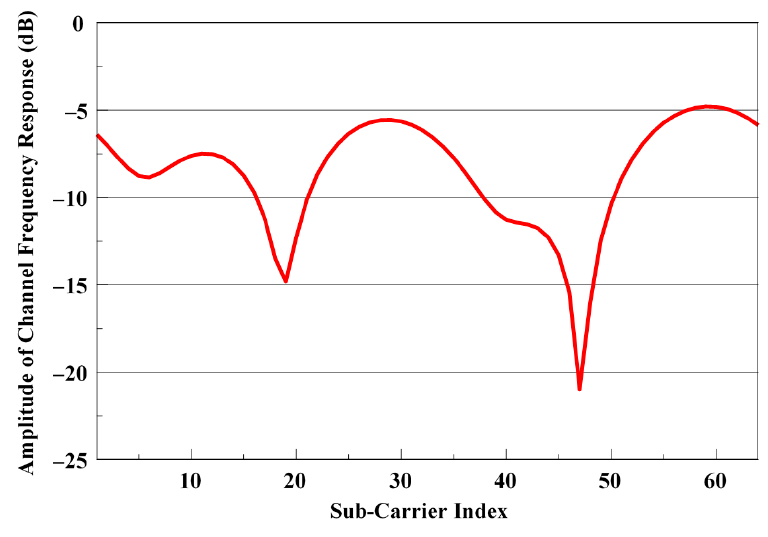
Figure 2. Frequency response of the wireless communication channel.